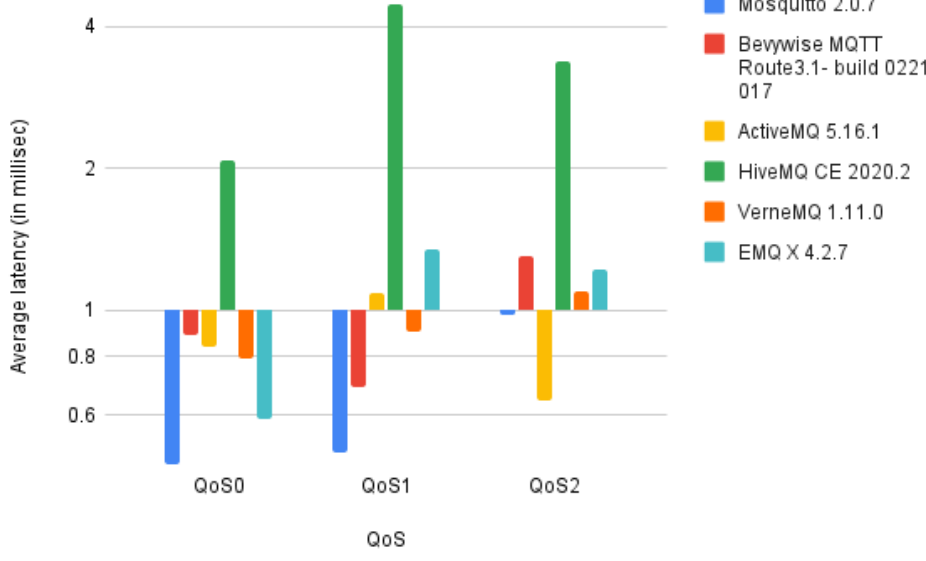
Figure 10. A comparison of average latency of all scalable and non-scalable brokers in the cloud evaluation